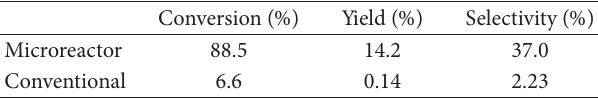
F 4: GC-MS reaction chromatogram of (a) 0min and (b) aer 30min reaction time. T 1: Performance of oxidation of benzene in microreactor and conventional